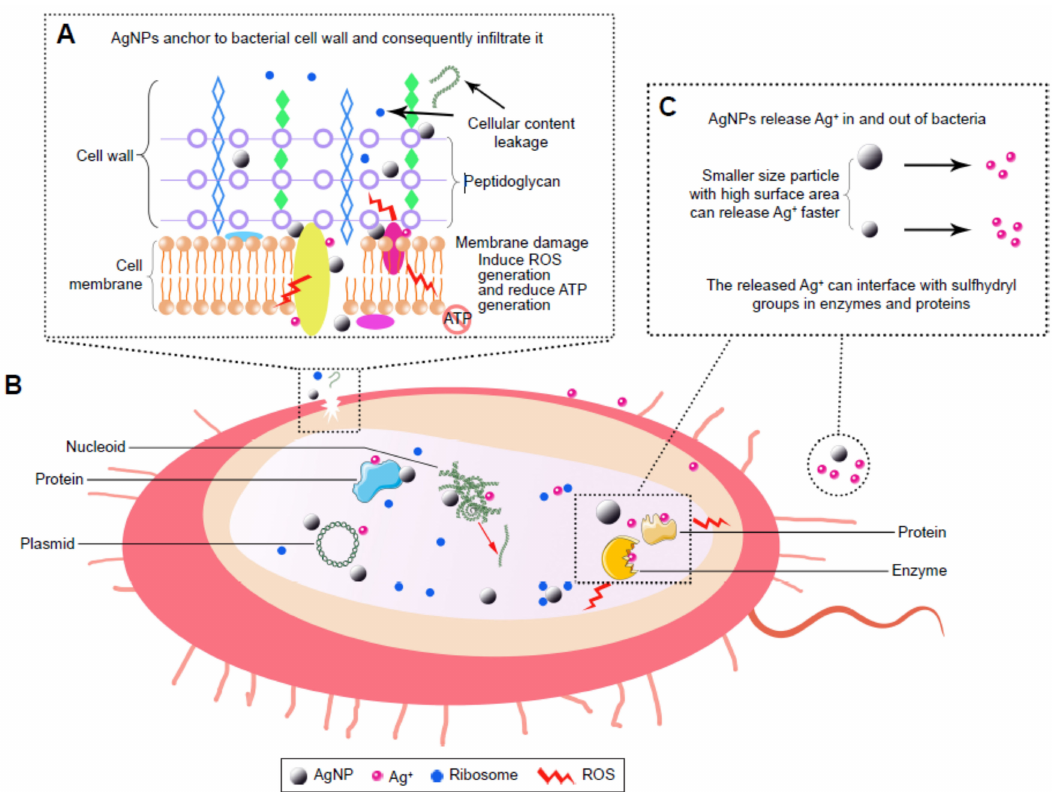
Figure 8. Antibacterial mechanism of AgNPs [71]. ( A ) Enlarged picture shows that AgNPs can anchor to the bacterial cell wall and consequently infiltrate it. This action can lead to membrane damage and cellular content leakage. AgNPs or Ag+ can bind to proteins present in the cell membrane involved in transmembrane ATP generation. ( B ) AgNPs can penetrate microbial cells, then join with released Ag+ to interact with cellular structures and biomolecules such as proteins, enzymes, lipids, and DNA. Increased ROS leads to an apoptosis-like response, lipid peroxidation, and DNA damage. ( C ) AgNPs can sustainably release Ag+ in and out of bacteria and Ag+ can provide interactions with proteins and